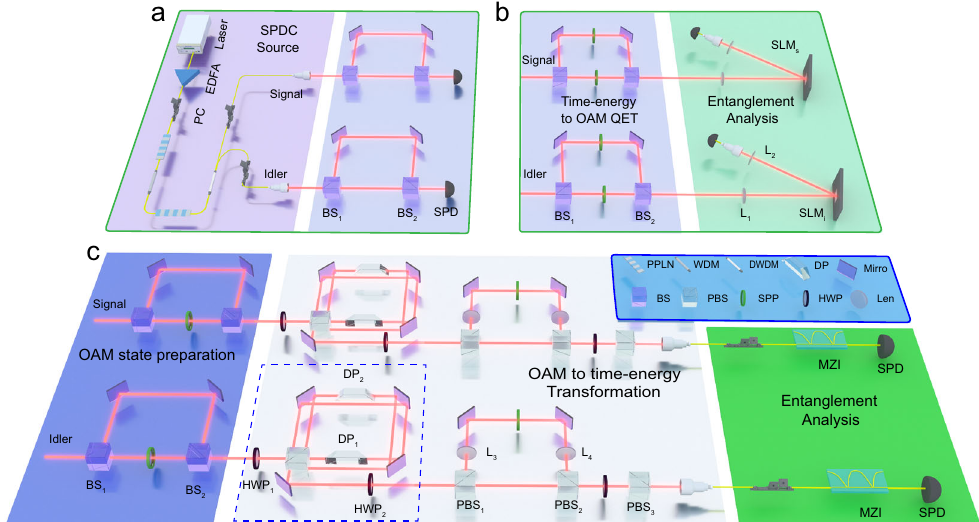
Fig. 1 Experimental setup. a Schematic of the experimental setup of Spontaneous parametric down-conversion (SPDC) source. Two MZIs serving as a Franson-type interferometer are used to characterize the time entanglement of the photon pairs. b Schematic of the experimental setup for characterizing the OAM entanglement. c Schematic of the main experimental setup of two-way entanglement transfer. The dashed box indicates the structure of OAM mode sorter which is implemented as a double-path Sagnac interferometer and contains two DPs with a relative angle of 90 ∘ . The photon pairs, signal and idler shown in b and c , are generated by the SPDC source shown in a . All the MZIs used in the experiment are steadily phase-locked by piezoelectric transducer systems. EDFA erbium-doped fi ber ampli fi er, WDM wavelength-division multiplexing, DWDM dense wavelength division multiplexing fi lter, PC polarization controller, L 1 len of f 1 = 300 mm, L 2 len of f 2 = 500 mm, L 3 and L 4 lens of f 3 = f 4 = 150 mm, DP Dove prism, SPP spiral phase plate, HWP half-wave plate, BS 50:50 beam splitter, PBS polarization beam splitter, MZI 1-GHz unbalanced Mach-Zehnder interferometer, SPD single-photon detector (quantum ef fi ciency, η = (10.0 ± 0.2)%; repetition frequency of gate, f = 50 MHz; width of gate, 1 ns; dark count probability per nanosecond, D = 1 × 10 − 6 ).